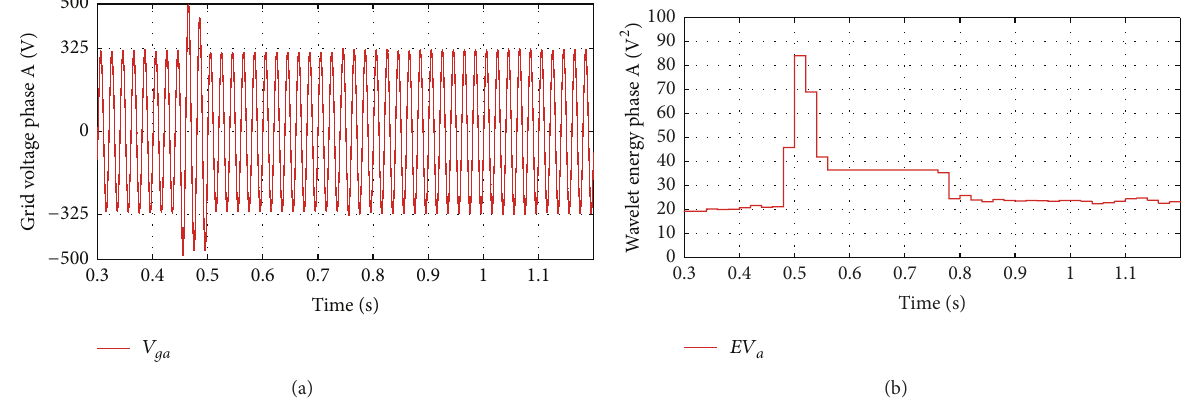
Figure 13: (a) Voltage signal and (b) corresponding wavelet energy plot of phase A.